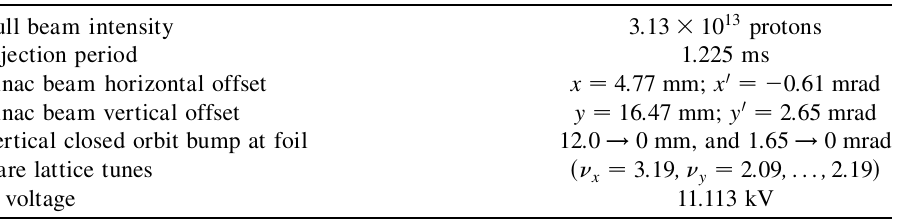
TABLE II. Parameters for the Tunescan Experiment.